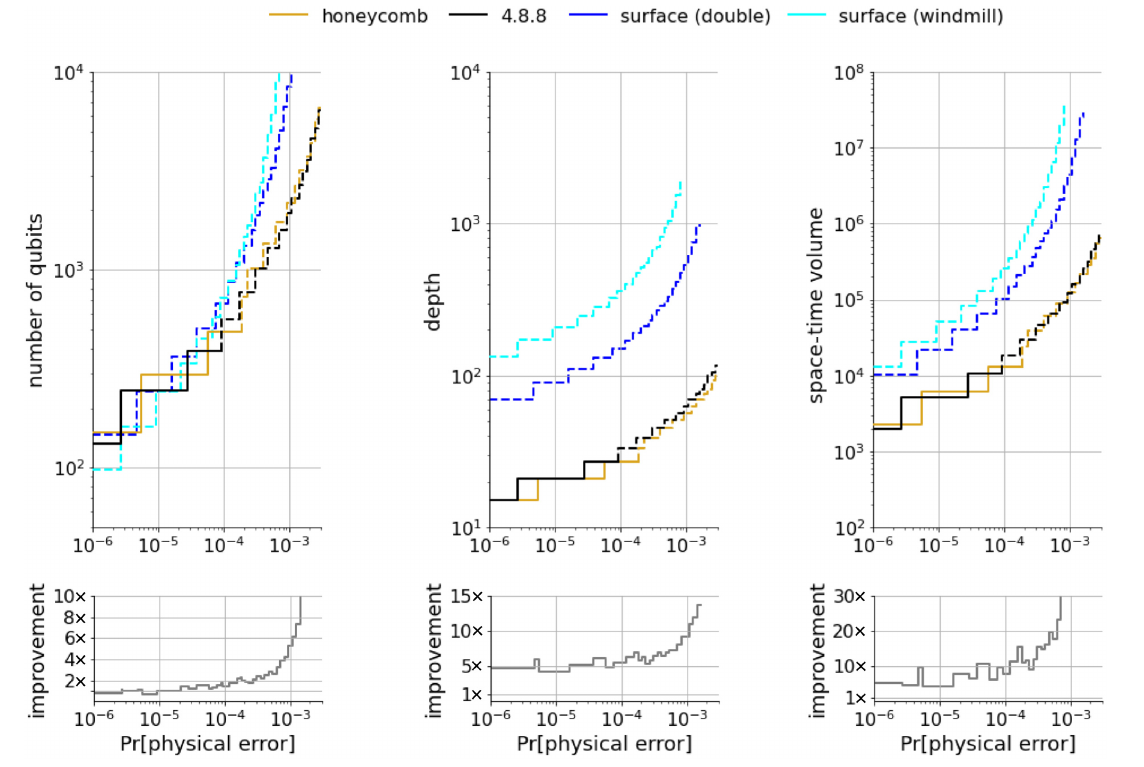
FIG. 9. Overhead estimates for a target logical error rate of 10 − 12 with respect to (a) the number of qubits (space), (b) the measure- ment depth (time), and (c) the space-time volume (number of qubits × measurement depth). The solid lines are based on empirical estimates from Fig. 8(a), while the dashed lines are based on heuristic estimates from Figs. 8(b) and 8(c). For reference, corresponding surface-code estimates from Ref. [27] are shown in blue. The gray lines along the bottom show the improvement factor of the Floquet codes relative to the surface code. They are obtained by taking the minimum of the two surface-code values (double or windmill), the minimum of the two Floquet code values (honeycomb or 4.8.8), and computing the ratio